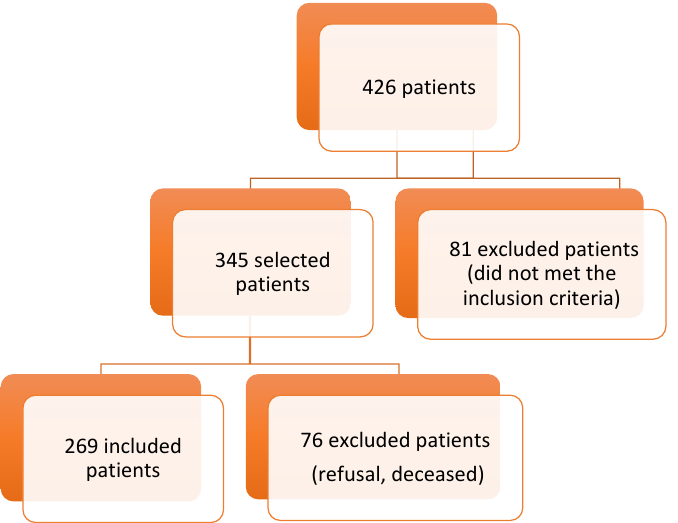
Figure 6. Flowchart of patient selection.